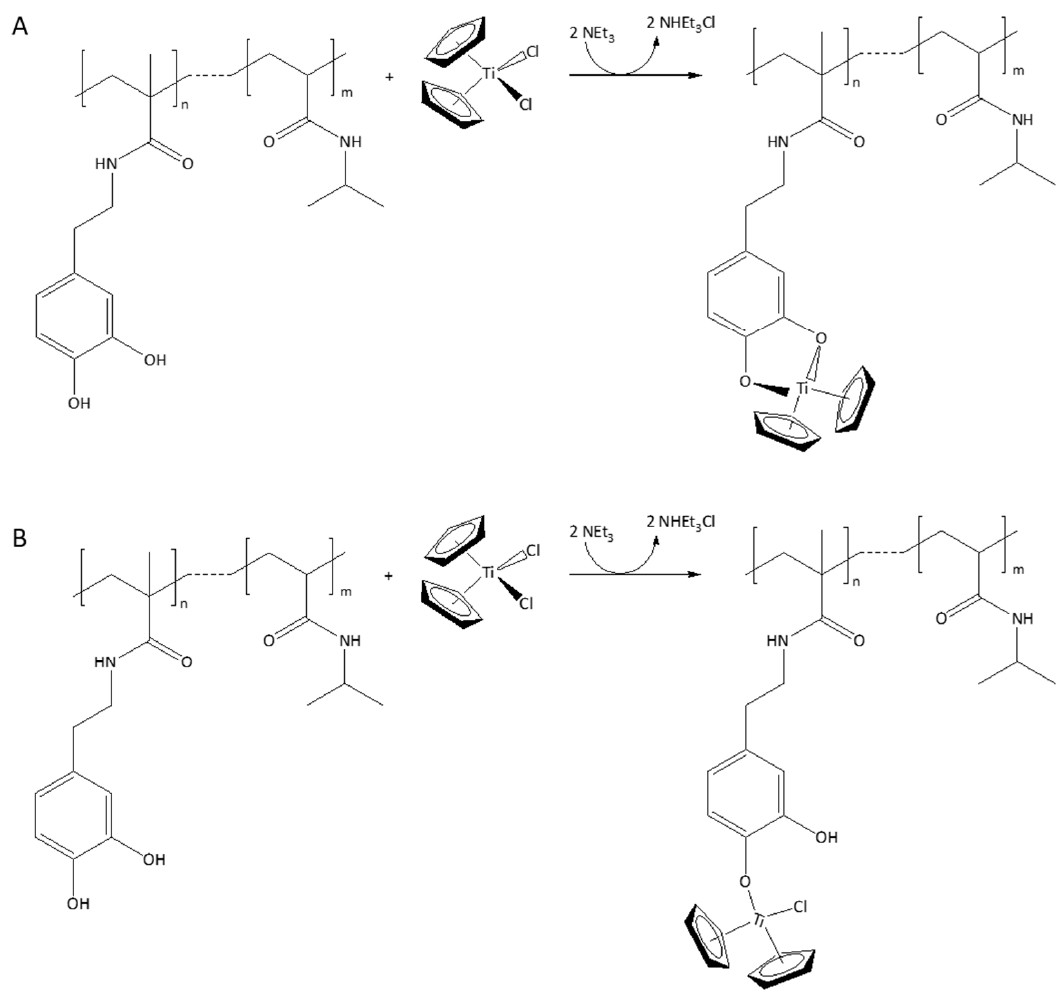
Scheme 1. Possible routes of functionalization between copolymer and organometallic complex through both OH groups ( A ) or a single OH ( B